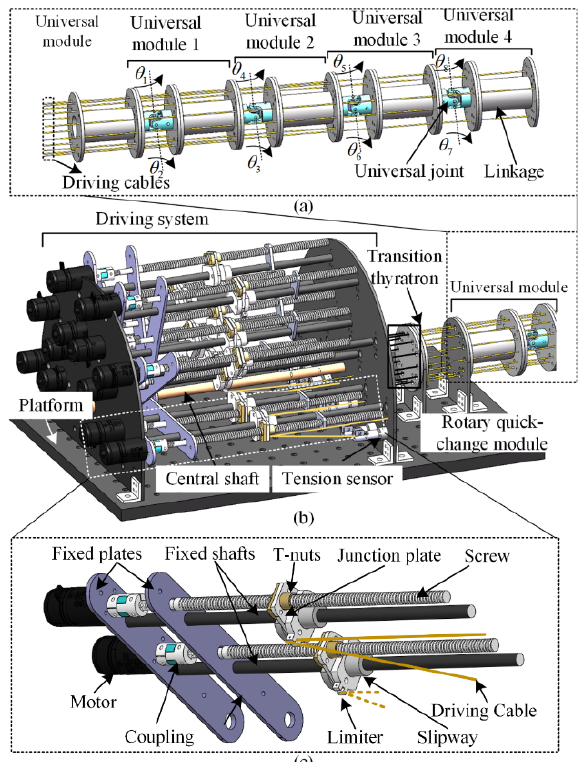
Figure 2. Structure of the cable-driven manipulator’s ( a ) universal module, ( b ) drive system, and ( c ) rotary quick-change module.